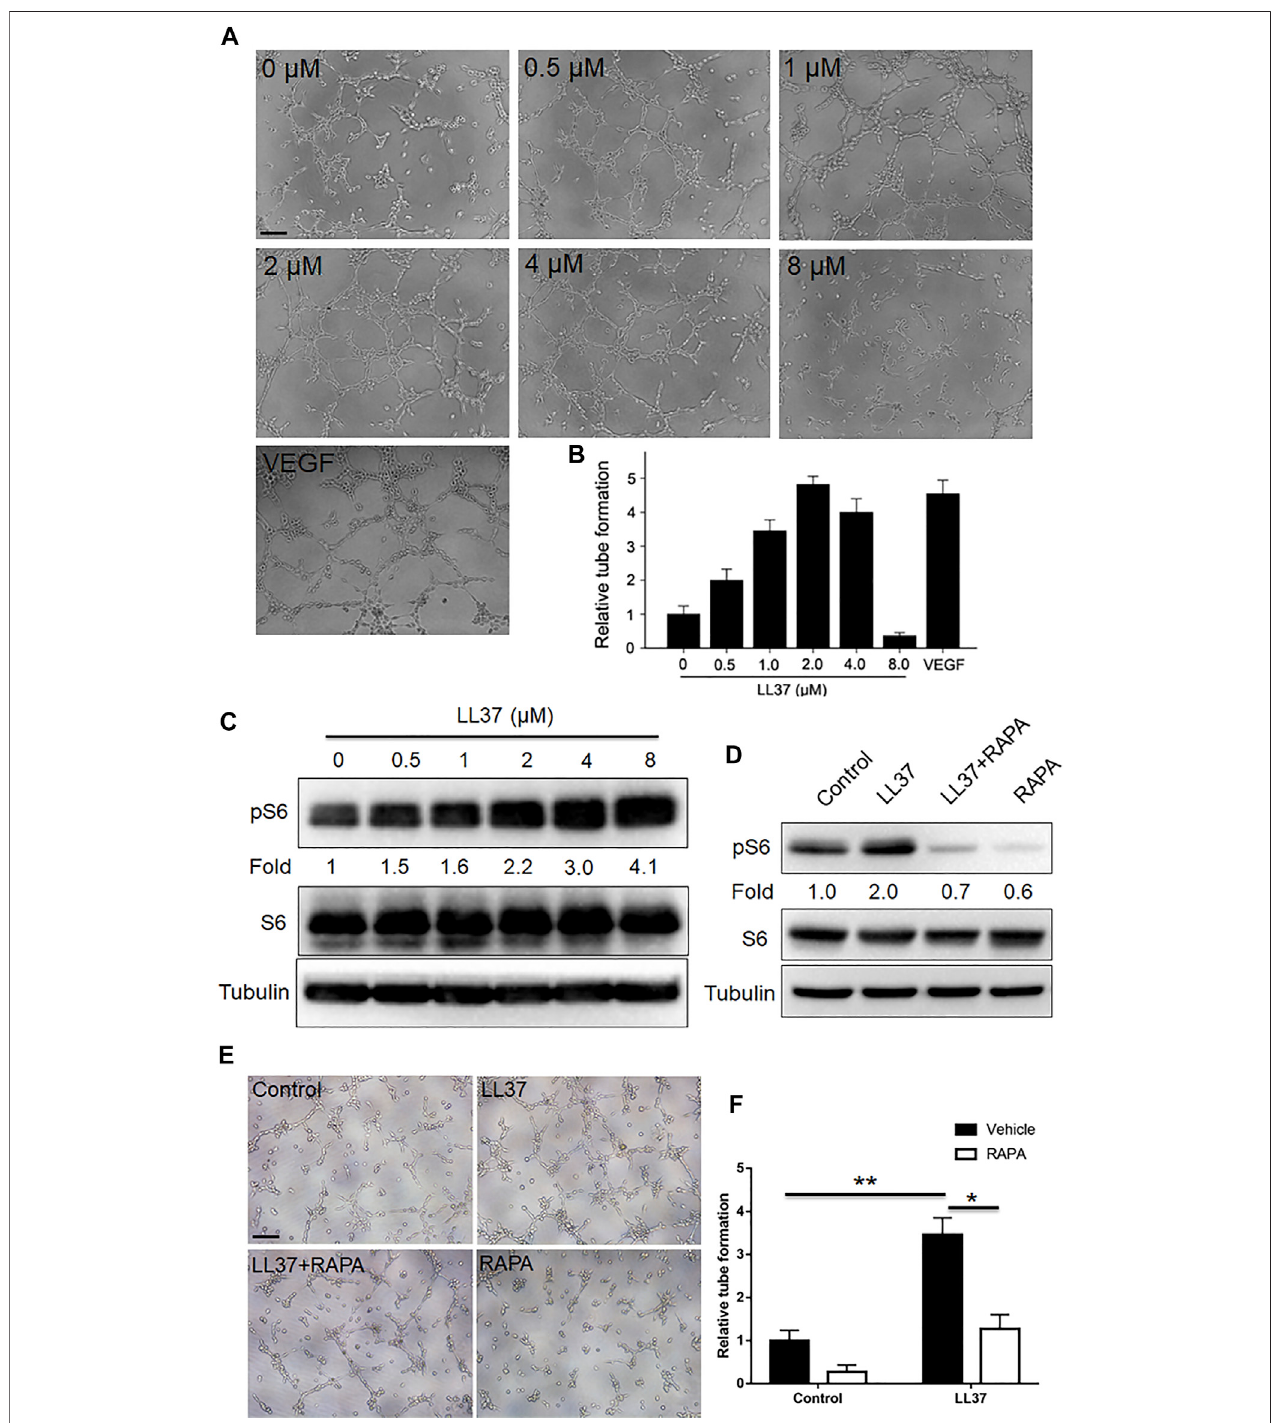
FIGURE 4 | mTORC1 signaling regulates the tube formation mediated by LL37 in HUVECs. (A) HUVECs tube formation assay in presence of LL37. VEGF-treated group was set as a positive control. (B) Quantitative analysis of the tubular structure in (A) . (C) pS6 and S6 protein levels in LL37-treated HUVECs by western blotting. Tubulin was taken as a loading control. pS6 protein level was analyzed relative to total S6. (D) pS6 and S6 protein levels in LL37 and/or RAPA-treated HUVECs. Tubulin was taken as a loading control. pS6 protein level was analyzed relative to total S6. (E) HUVECs tube formation assay treated with LL37 and/or RAPA. (F) Quantitative analysis of the tubular structure in (E) . Scale bar: 50 μ m. Data represent mean ± SEM from three independent experiments. Statistical signi fi cance was determined by One-way ANOVA (B,F) . * p < 0.05 and ** p < 0.01.